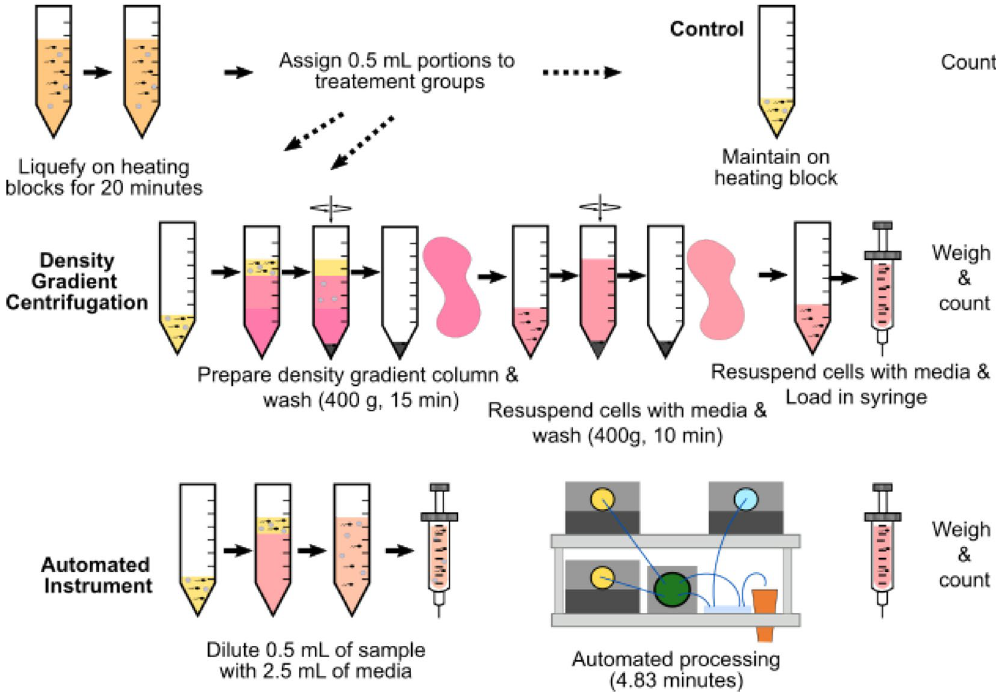
Figure 3. Presentation of experimental method. After the sample is liquefied, 0.5 mL portions are assigned to one of three treatment groups: The control portion remains on the heating block for the duration of the test. The density gradient centrifugation portion has two centrifugation steps before being resuspended in media. The automated instrument portion is diluted with 2.5 mL of media and then processed in the automated